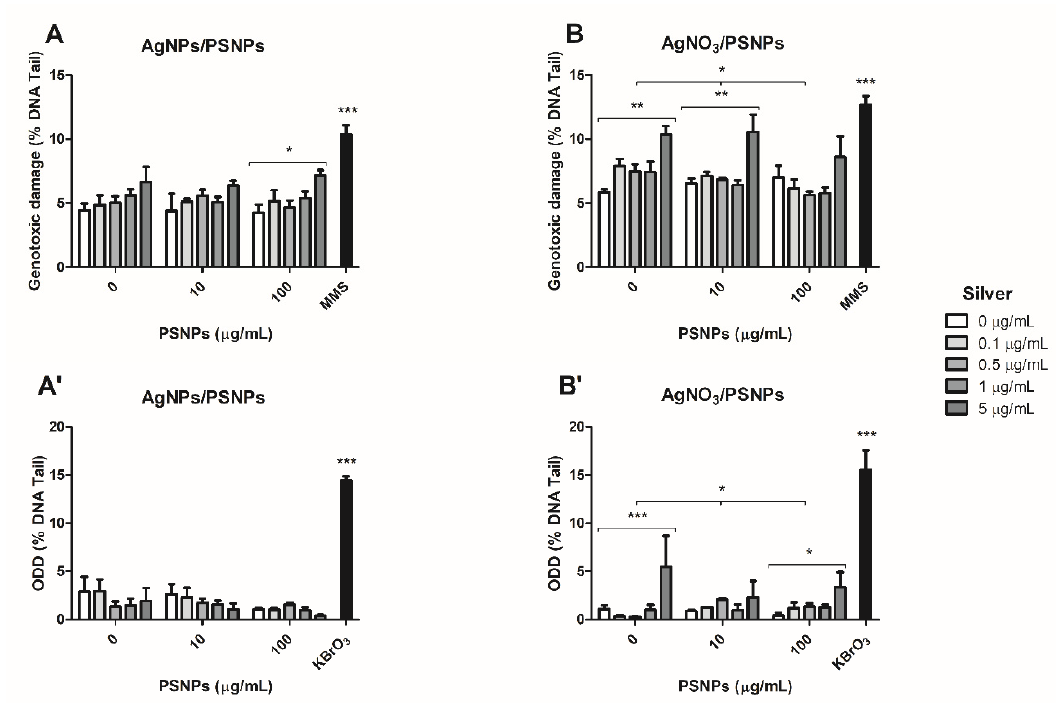
Figure 8. Genotoxic damage detected with the comet assay after 24 h of AgNPs/PSNPs ( A ) or AgNO 3 /PSNPs ( B ) exposures, using 200 µ M MMS as a positive control. Oxidative DNA damage (ODD) detected using the FPG enzyme after 24 h of AgNPs/PSNPs ( A ’) or AgNO 3 /PSNPs ( B ’) exposures, using 5 mM KBrO 3 as a positive control. Three independent experiments were performed with duplicates and 100 randomly selected cells were analyzed by the software. Genotoxic and oxidative DNA damage are extrapolated from the percentage of DNA in the comets’ tail. Data represented is the result of averaging the three experiments. For ODD calculation we subtracted genotoxic damage from general damage for each experiment and averaged the resulting values. Data are represented as mean ± SEM and analysed by one-way ANOVA with linear trend post-hoc test. Brackets indicates the group of samples for which significant linear trend is shown. * p ≤ 0.05, ** p ≤ 0.01, *** p ≤ 0.001